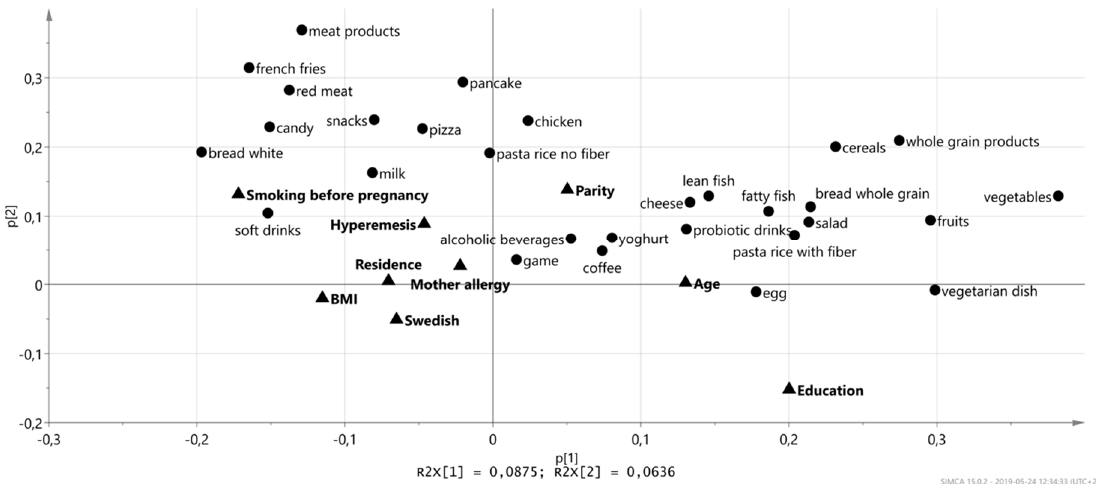
Figure 5. Loading plot from the principal component analysis (PCA) of selected food items and selected maternal characteristics. Food items that were found to be correlated to different maternal characteristics in the heat map models were aggregated with the maternal characteristics in a PCA model.